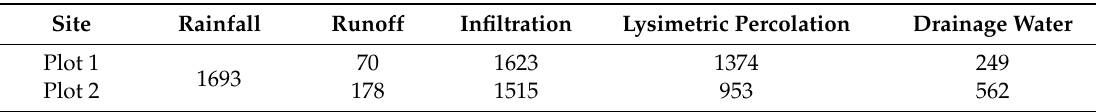
Table 2. Water flux components during only the periods when hydrological measurements were collected. Units are in